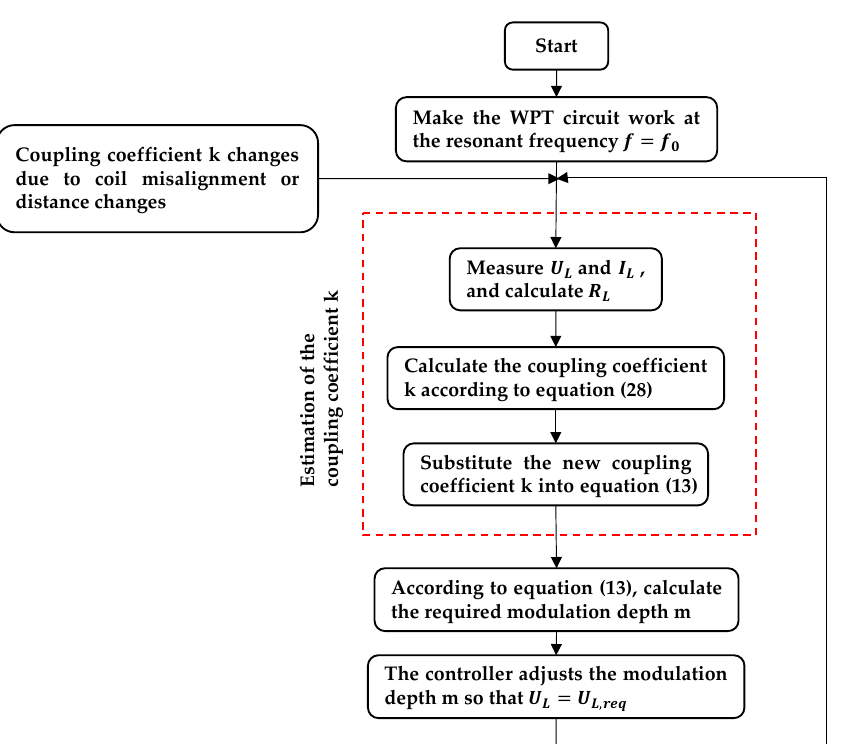
Figure 8. Flow chart of modulation depth adjustment based on coupling-coefficient estimation in CV mode.